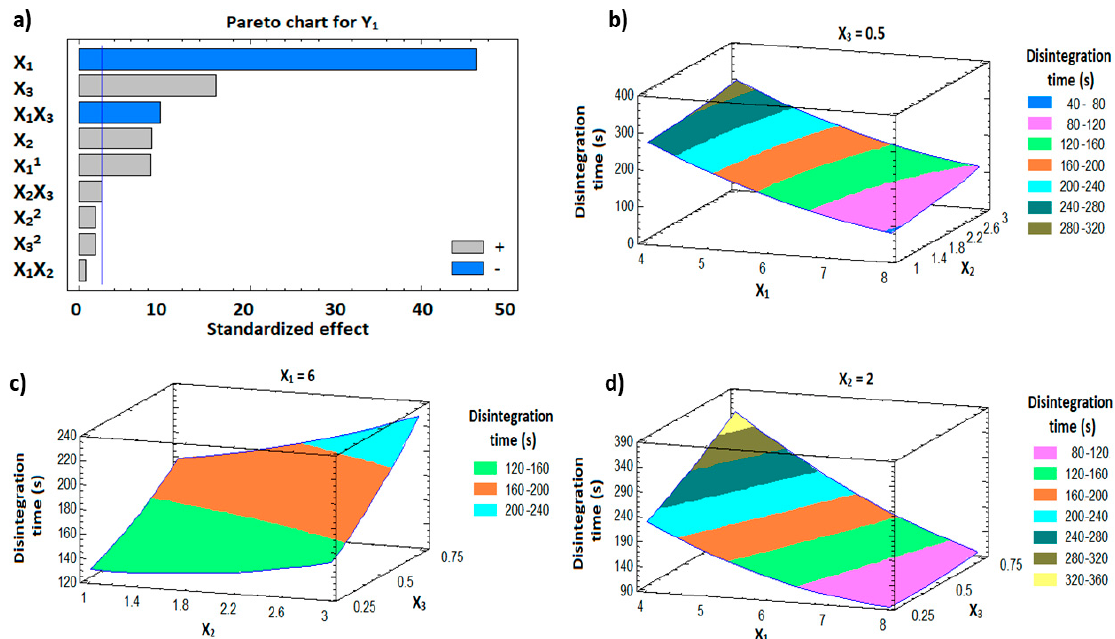
Figure 5. Pareto chart ( a ) and response surface plots ( b – d ) showing the effect of the independent variables on the disintegration time (Y 1 ).